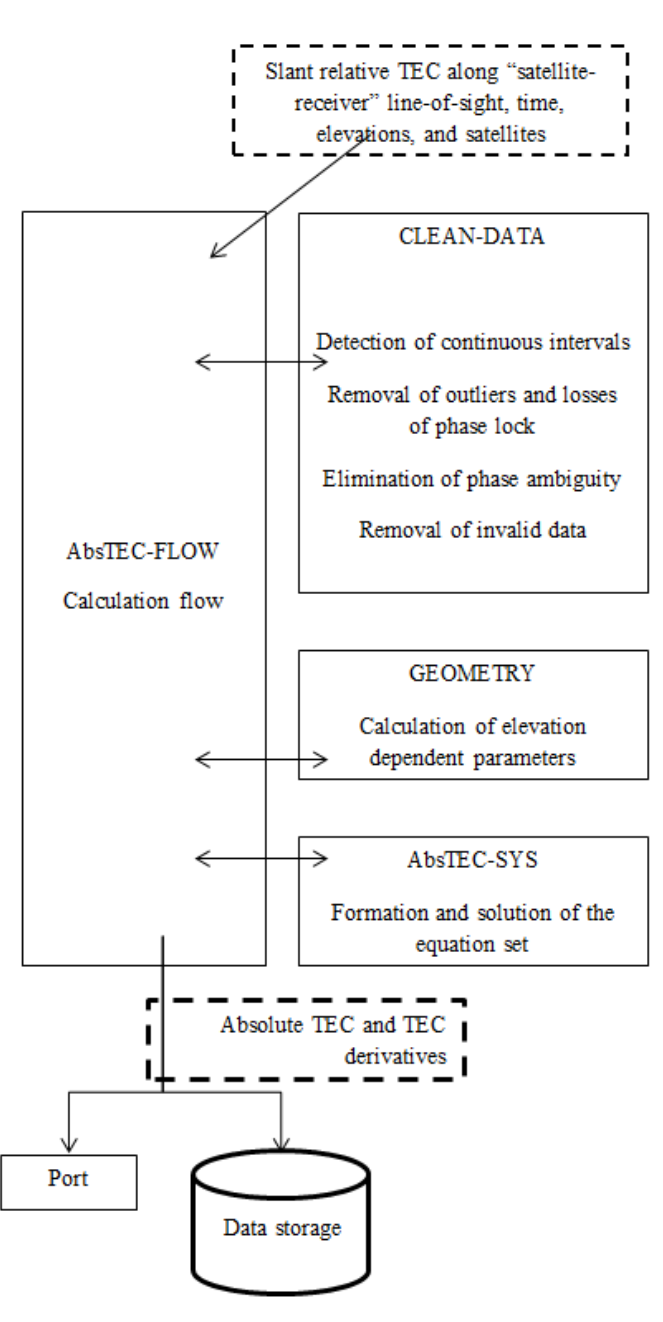
Figure 6. Information pattern for the absolute TEC obtaining module.